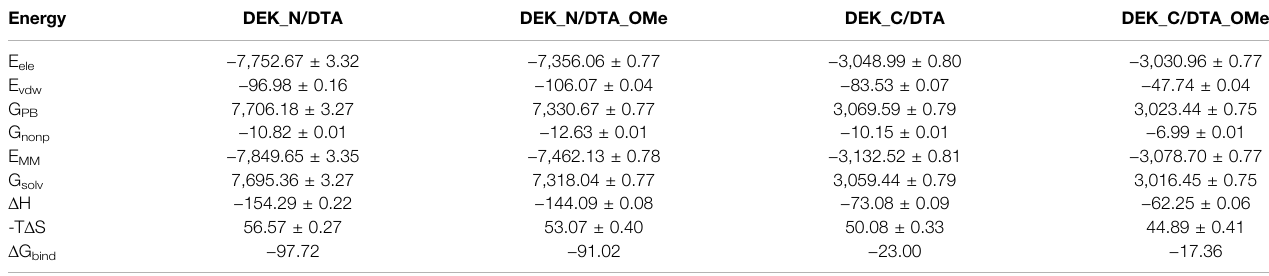
TABLE 2 | Binding free energy ( Δ G bind ) and its components (E ele , E vdw , G PB , G nonp , E MM , G solv , and -T Δ S) of each protein – DNA complex and the corresponding standard error of the mean (unit: kcal/mol).